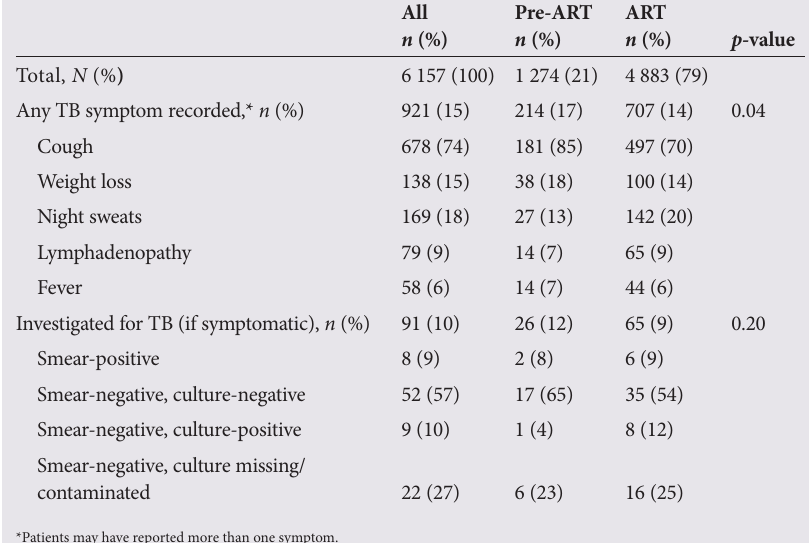
Table 2. Intensified TB case finding during 6 157 clinic encounters among 4 079 individual PLWH at 3 primary care clinics in Johannesburg All n (%)